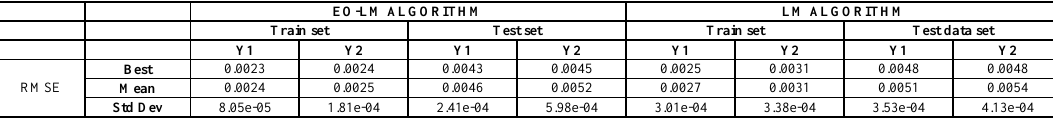
Table 2. Comparison between the EO-LM and LM on CSTR Model EO-LM